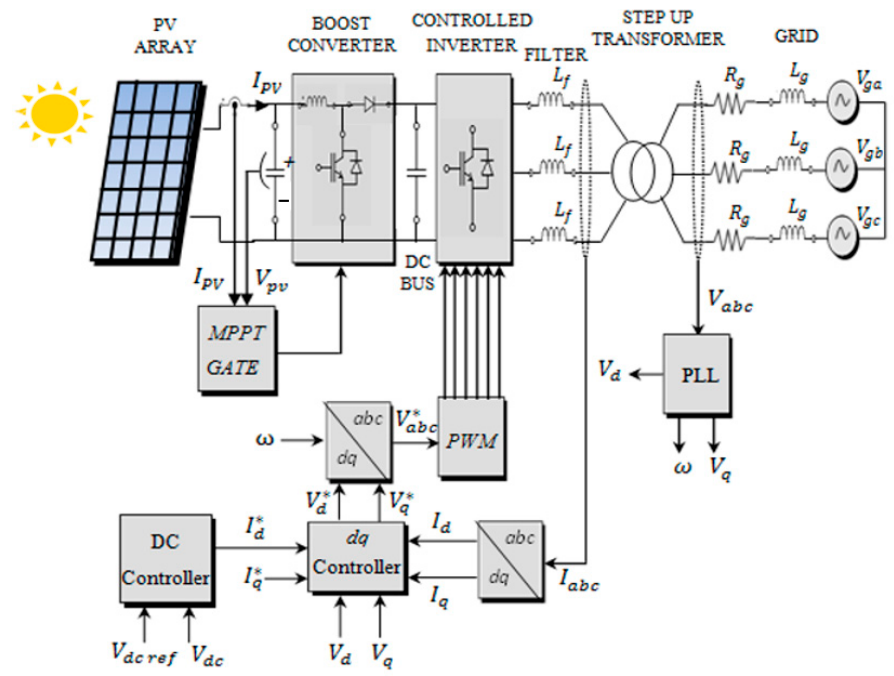
Figure 2. PV array connected to the grid.